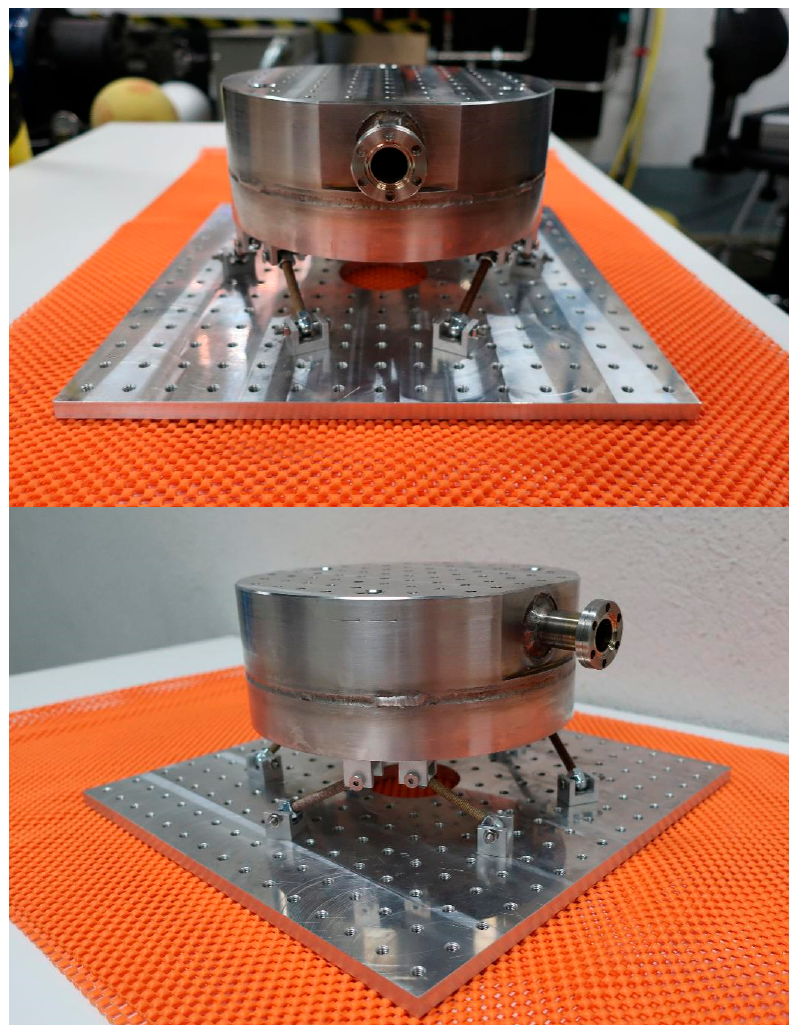
Figure 15. Complete structure after final assembly: Front ( top ) and lateral ( bottom ) views.